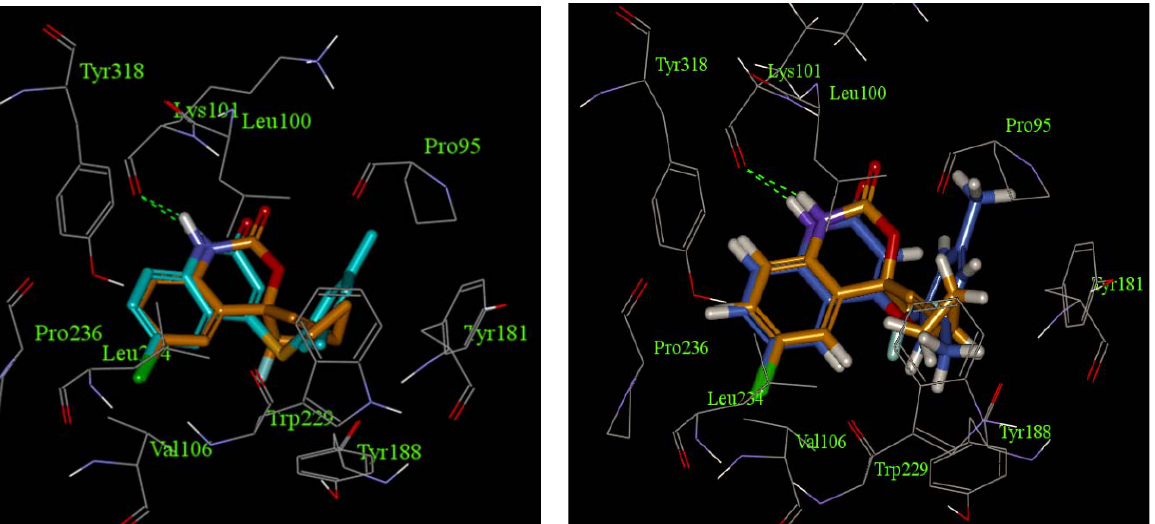
the crystal structure (1FK9 in PDB) of efavirenz (orange colored carbon atoms). The key hydrogen bond is illustrated with green